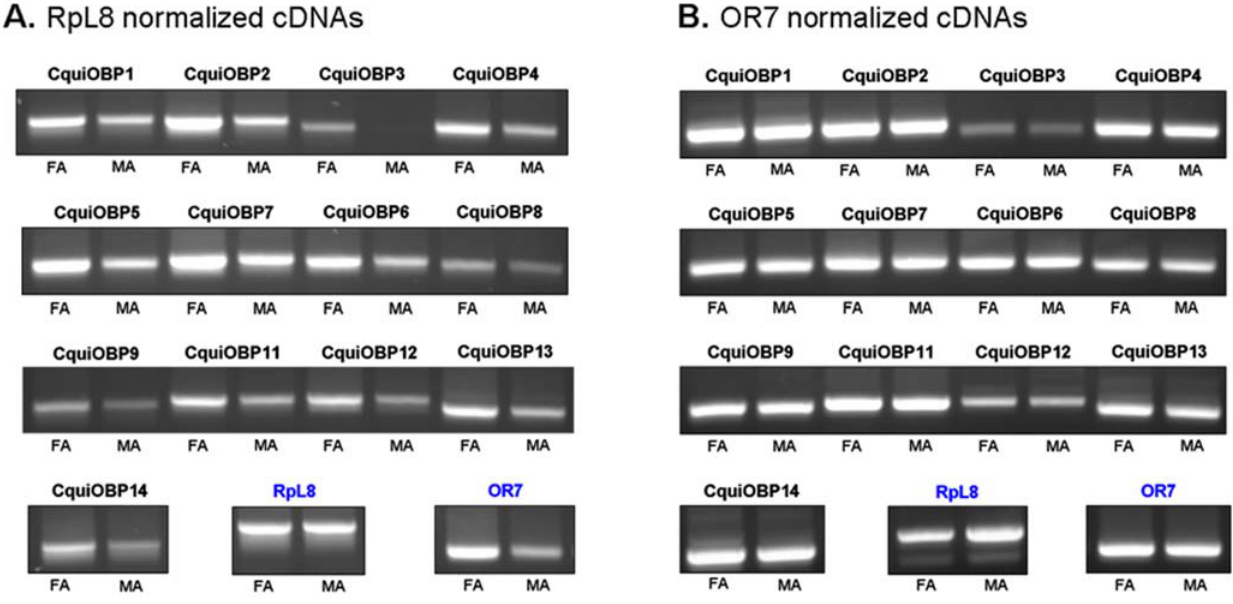
Figure 6. PCR amplification in female and male antennae. Amplification of thirteen olfactory-specific OBP genes and two control genes (RpL8, OR7) in female antennae (FA) and male antennae (MA) cDNAs. (A) cDNAs normalized to the expression levels of CquiRpL8; (B) cDNAs normalized to the expression levels of CquiOR7.